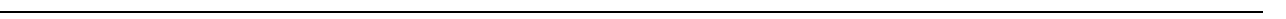
Fig. 5 Post-RNA synthesis DNA promoter scrunching kinetics are independent of the presence of NTP. a Schematic of the RPs possible behavior and the corresponding FRET signal. b Schematic of the experiment. c Table presenting the experimental variables probed in Fig. 5. Note that the data represented in brown and yellow are from Fig. 2 and are averaged (avg) values for all the concentration of NTP probed in these experiments. Here, we used the WT DNA promoter (Supplementary Fig. 1) and wild-type holoenzyme (Methods). d Ratio of the numbers of active FRET pairs, i.e., that display scrunching/ unscrunching cycles, over the total number of FRET pairs after selection (Methods: FRET pair localization and detection). The + and – above the bars indicate the presence and the absence, respectively, of NTPs during the experiment. An identical notation is used in f and h . e Experimental FRET trace after NTP removal b showing an RP complex alternating between US and PS, but not in the FS FRET level. The experimental conditions used for the acquisition of this trace correspond to the light green color code in c . f Scrunching kinetics ( k 1 , k 2 , and P ( k 1 )) extracted from a double-exponential MLE fi t analysis of the Δ t Δ t US and PS distributions from the traces alike e . g Experimental FRET trace after NTP removal (as in b ) showing an RP complex alternating between US, PS and FS FRET level. h Scrunching kinetics ( k 1 , k 2 , and P ( k 1 )) extracted from a double-exponential MLE fi t analysis of the Δ t US , Δ t PS , and Δ t FS distributions from the traces alike g for the conditions described in c . i 3D histogram showing the number of transition between two different FRET levels for two consecutive dwell times n and n + 1 for the traces acquired as described in c . j Schematic representing the results of i ; we use wavy arrows to highlight that these are complex transitions involving two timescales; the thicker the arrow, the more likely the transition. k Transcript retention experiment using magnetic-bead-attached RP complexes incubated in ITC7 conditions and rinsed (i), then restarted after 15 s by chasing 80 µ M GTP (ii) (Supplementary Protocol in Supplementary Methods). The 9mer and 11mer originated from GTP